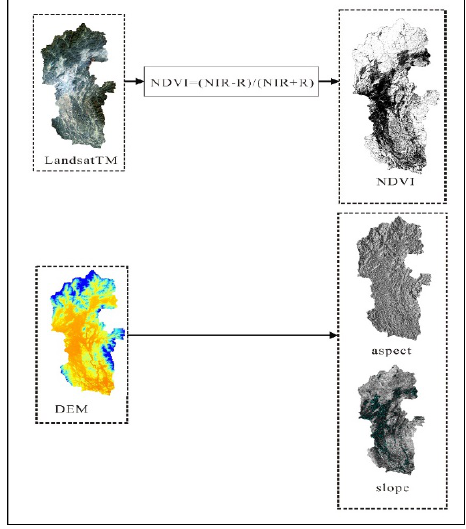
Figure 1. Extraction process diagram of each factor